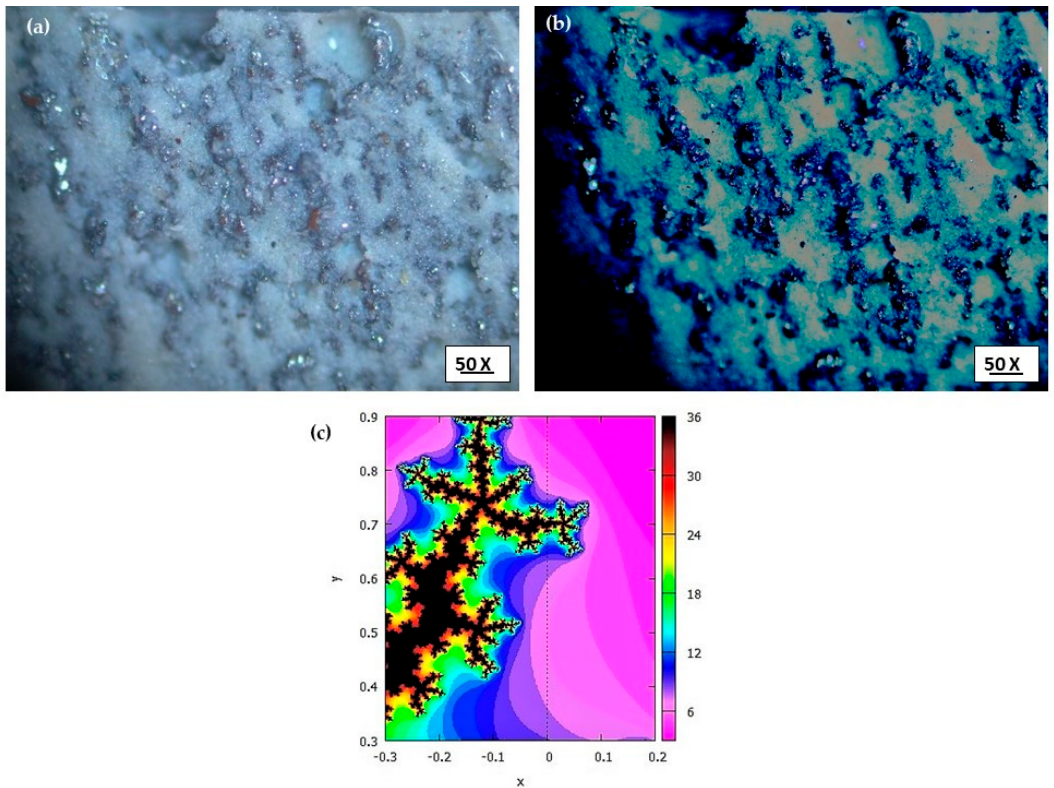
Figure 1. Optical images ( a , b ) of the linear arrangement of filler particles within the magneto-rheological elastomers (MREs) composite (N 1522 as matrix) in the presence of magnetic field during fabrication. ( c ) The linear chain and branches of filler particles.